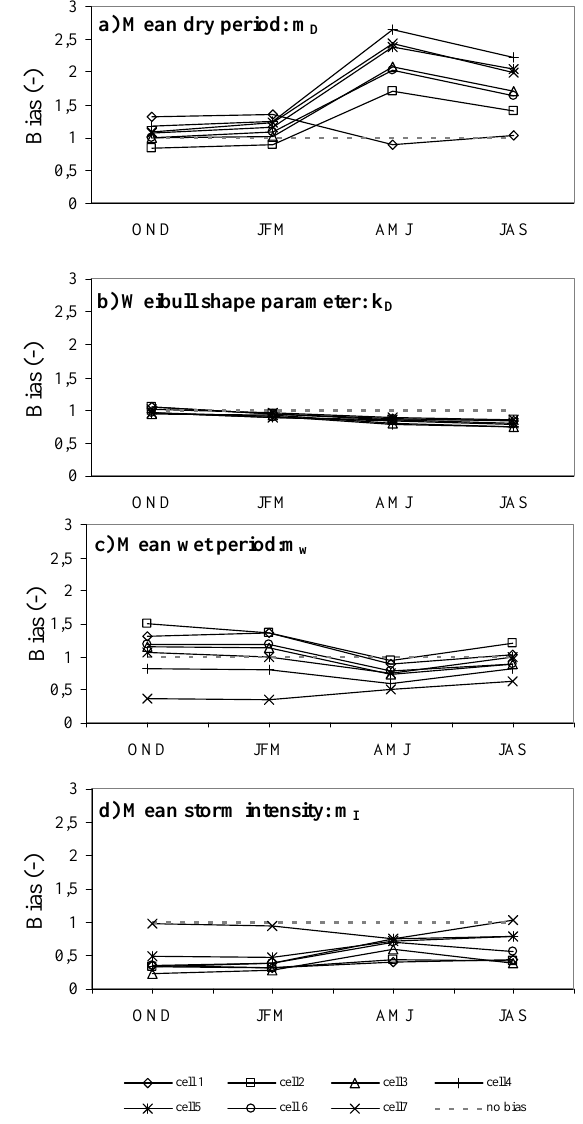
Fig. 6. Analysis of RCM predictive performance through the as- sessment of the model/observation bias of the following storm parameters: mean wet period ( m W ), mean dry period ( m D ), Weibull shape parameter ( k D ) and mean storm in- tensity ( m I ). The parameters are derived seasonally as maximum likelihood estimations for the reference period